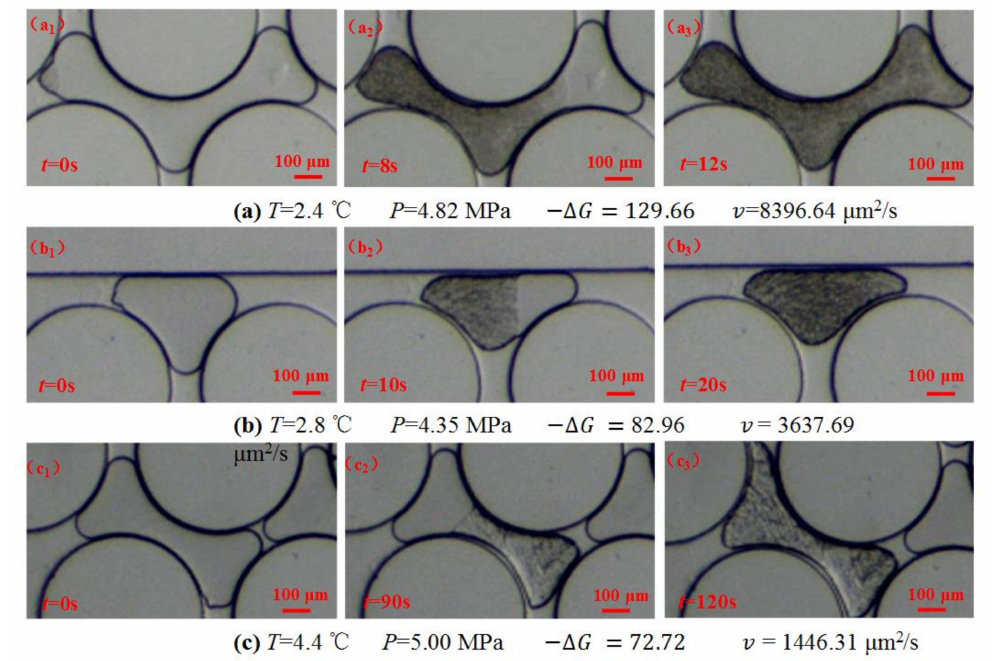
Figure 4. The typical evolutional morphological microscopic images of the lateral film growth at different driving forces ( a ) T = 2.4 ◦ C, P = 4.82 MPa; ( b ) T = 2.8 ◦ C, P = 4.35 MPa; ( c ) T = 4.4 ◦ C, P = 5.00